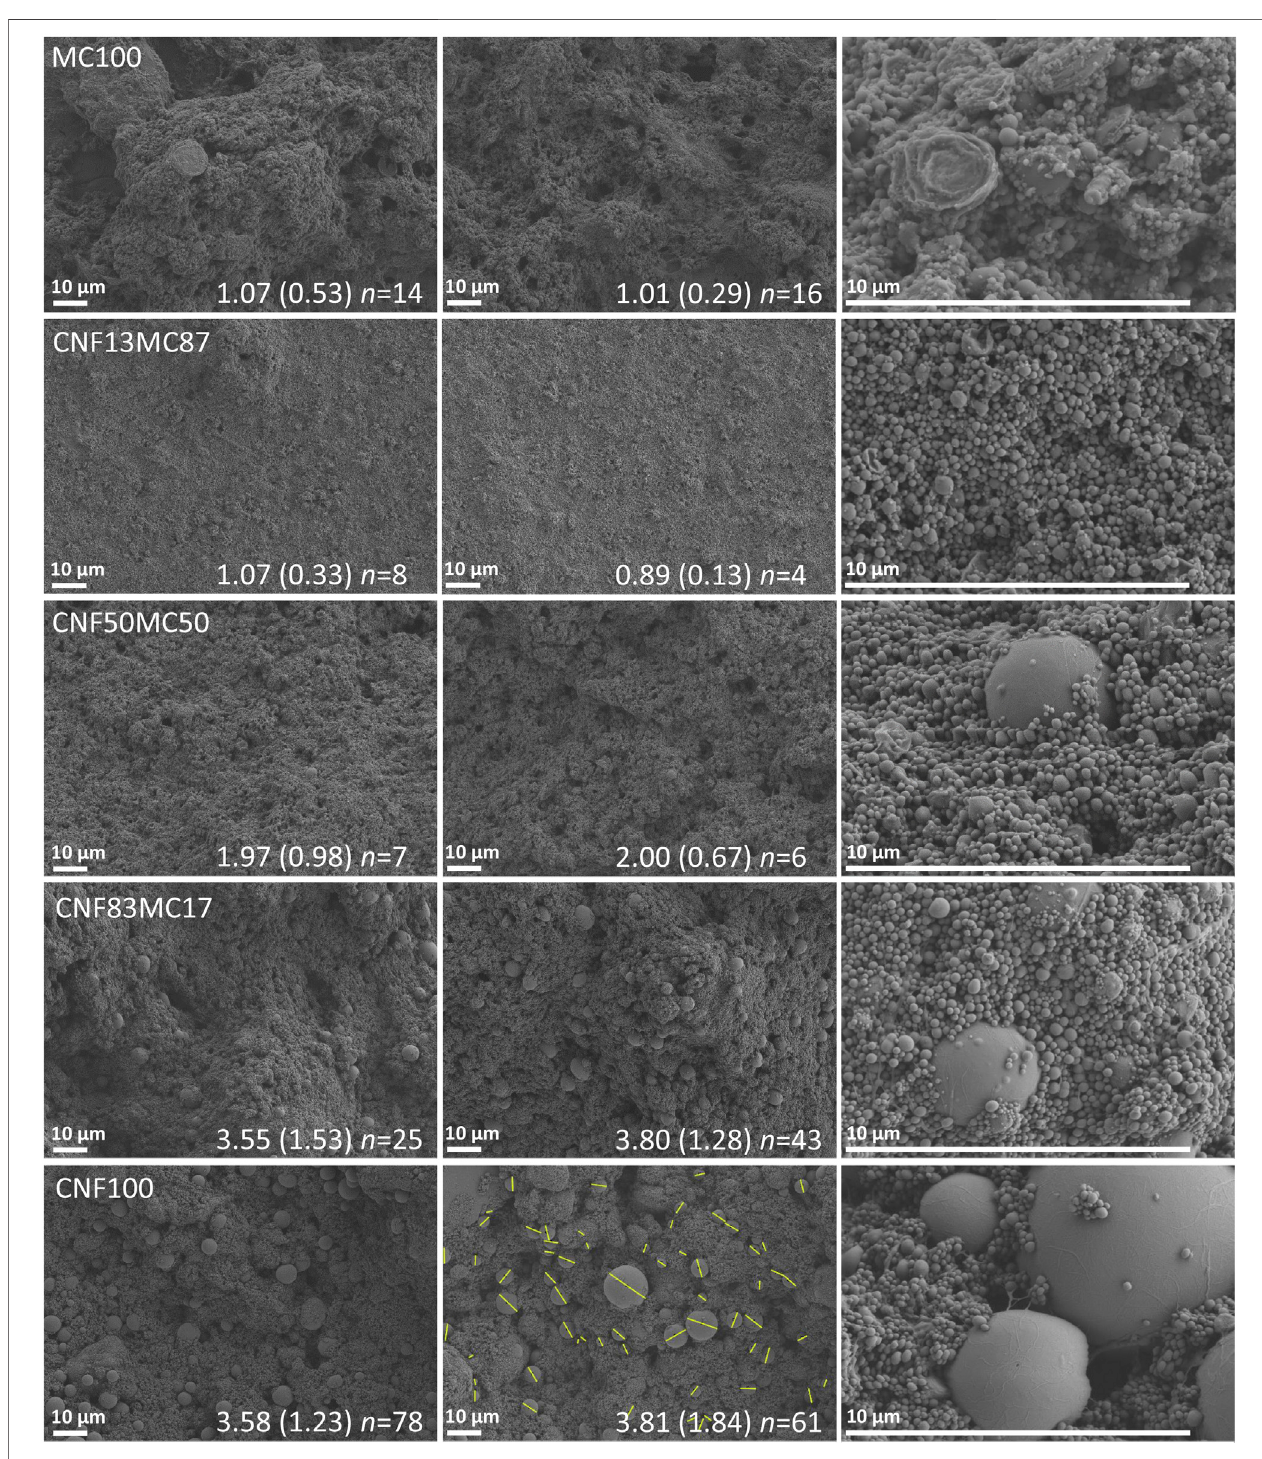
FIGURE3| SEMimagesofthedriedcreaminglayersprovidingthemeanbeaddiametersofthepolystyrenebeads(the left andthe middle column).Particlesizeof the larger polystyrene bead fraction has been evaluated from two representative SEM images of 100,00 × magni fi cation in which the smaller bead fraction appears as a blurry background. The inserts give the size of the larger bead fraction presented as “ mean diameter, µm (standard deviation) n (cid:2) number of measured beads ” . Larger magni fi cation images in the right side column depict the structure of the smaller bead fraction. The yellow lines in the center image on the CNF100 row are shown as an illustrative example of the size measurement of the larger bead fraction.